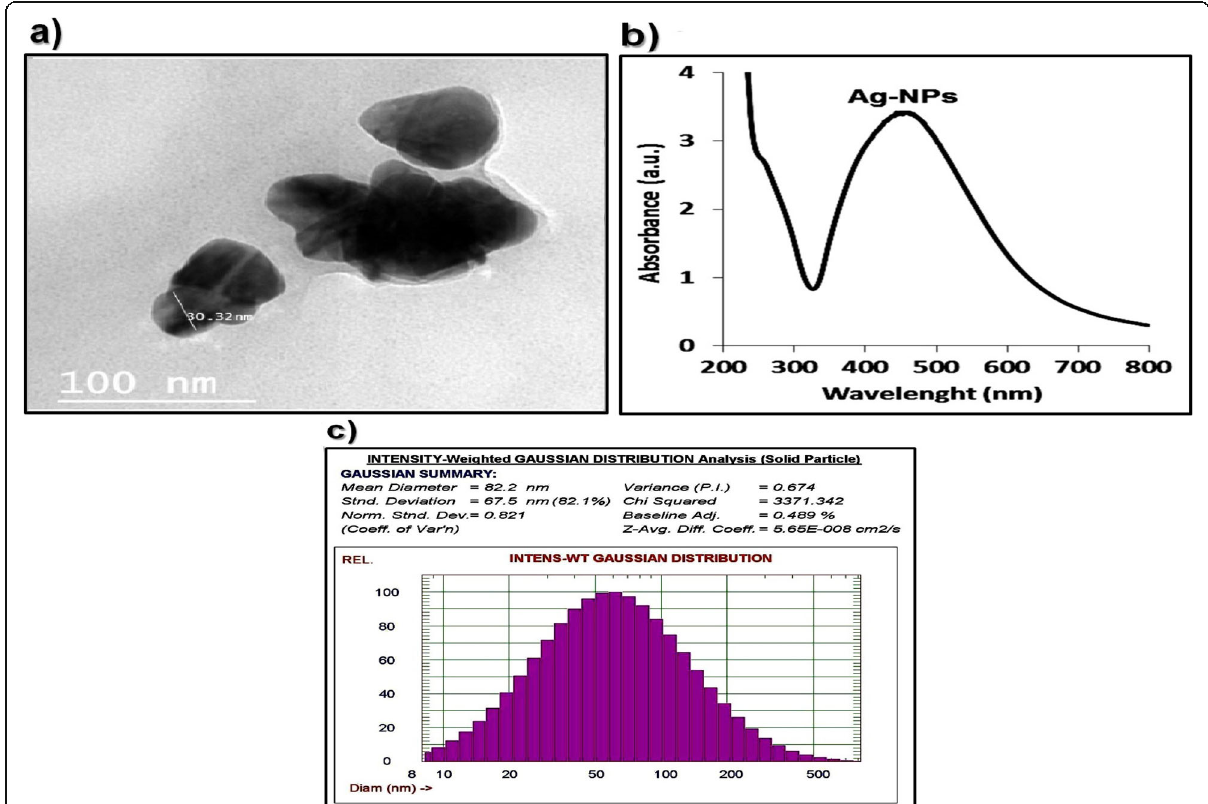
Fig. 1 a TEM image of Ag-NPs, b UV-spectroscopy of the prepared Ag-NPs, and c DLS of the Ag-NPs